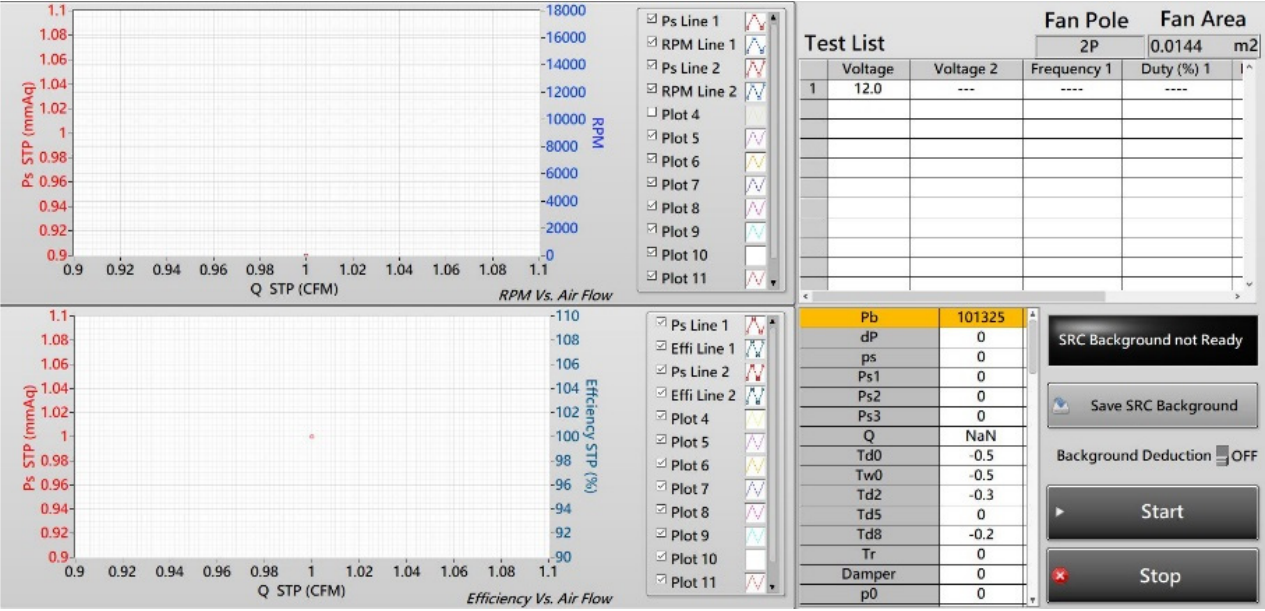
Figure 7. Data collection interface.